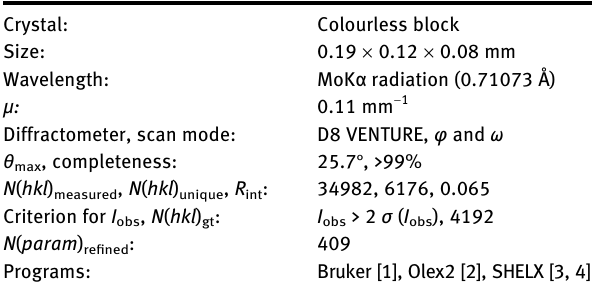
Table  : Data collection and